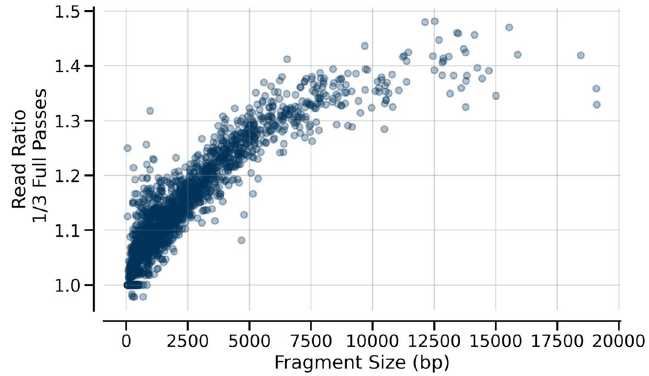
Figure 4. Impact of DNA size on CCS read frequency. The ratio of reads with CCS cycle set to 1 versus 3 is shown as a function of DNA size. At sizes of 1000 bp and below, there is little or no effect. The impact grows progressively larger with longer DNA